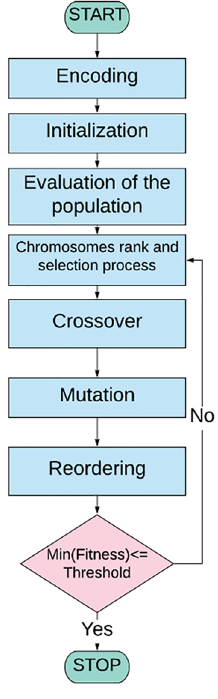
Figure 1. Flowchart of the Genetic Algorithm.